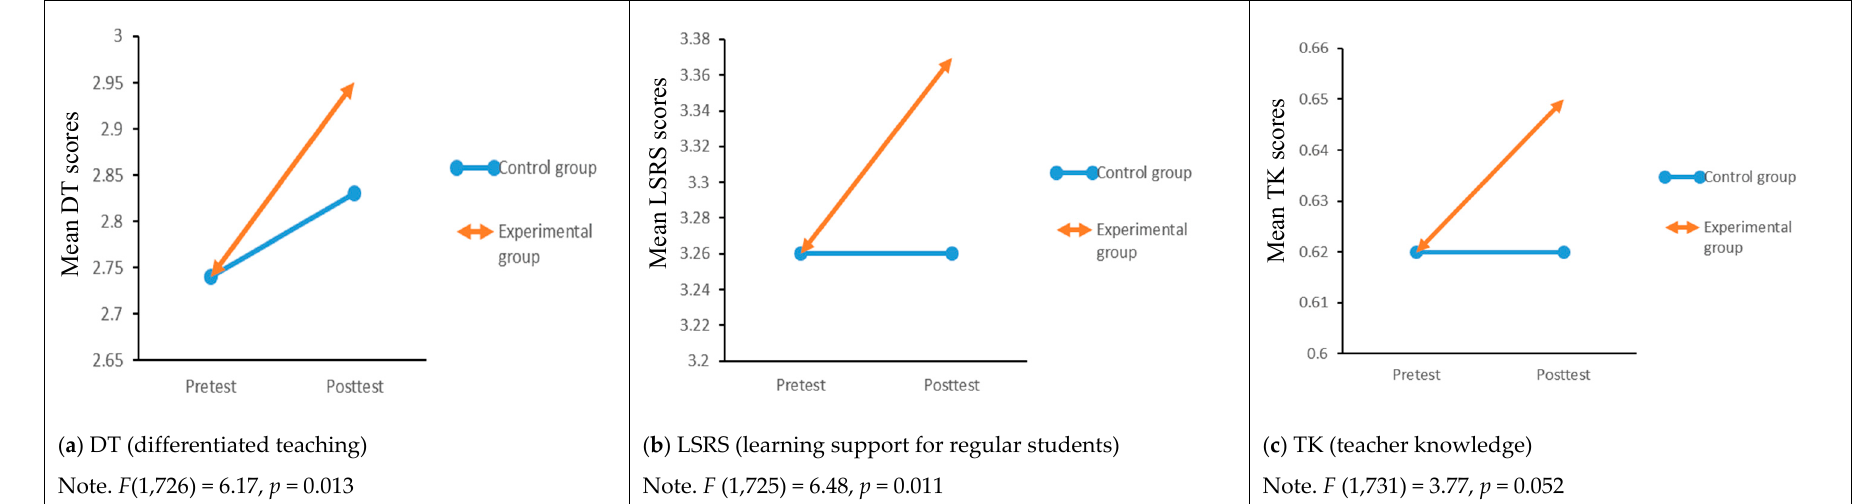
Figure 1. Graphs showing the difference in outcome variables at posttest from one-way ANCOVA between experimental and control groups.